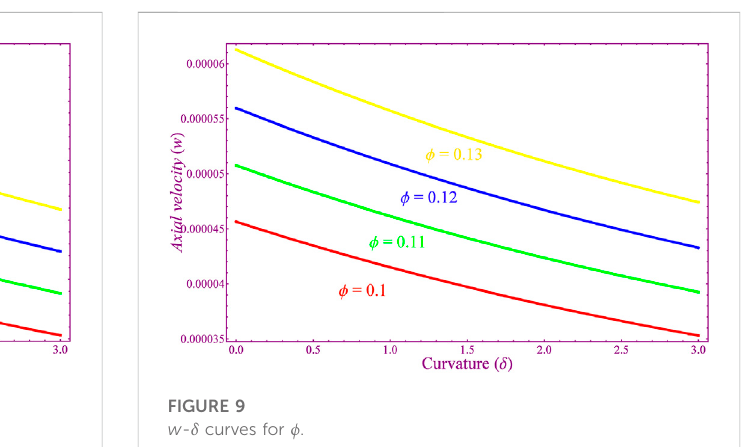
FIGURE 6 w - δ curves for α .